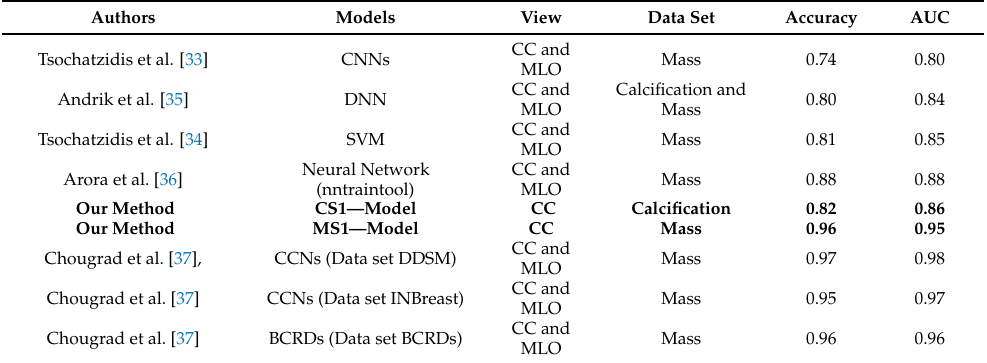
Table 8. CBIS-DDSM segmentation show the comparison of the results obtained using the method- ologies proposed in